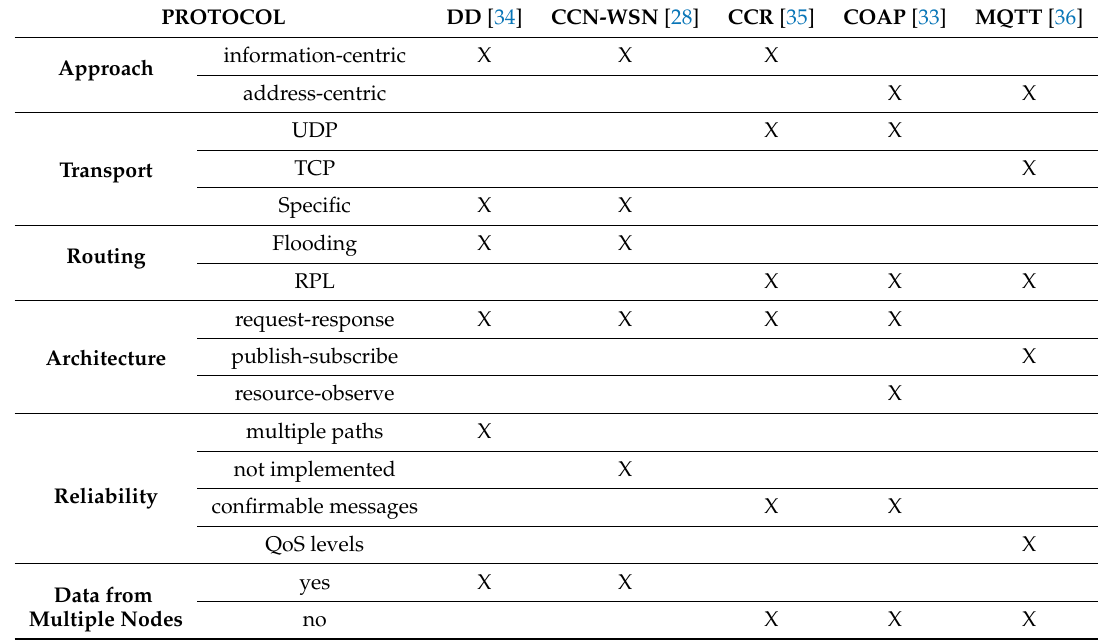
Table 1. Protocol